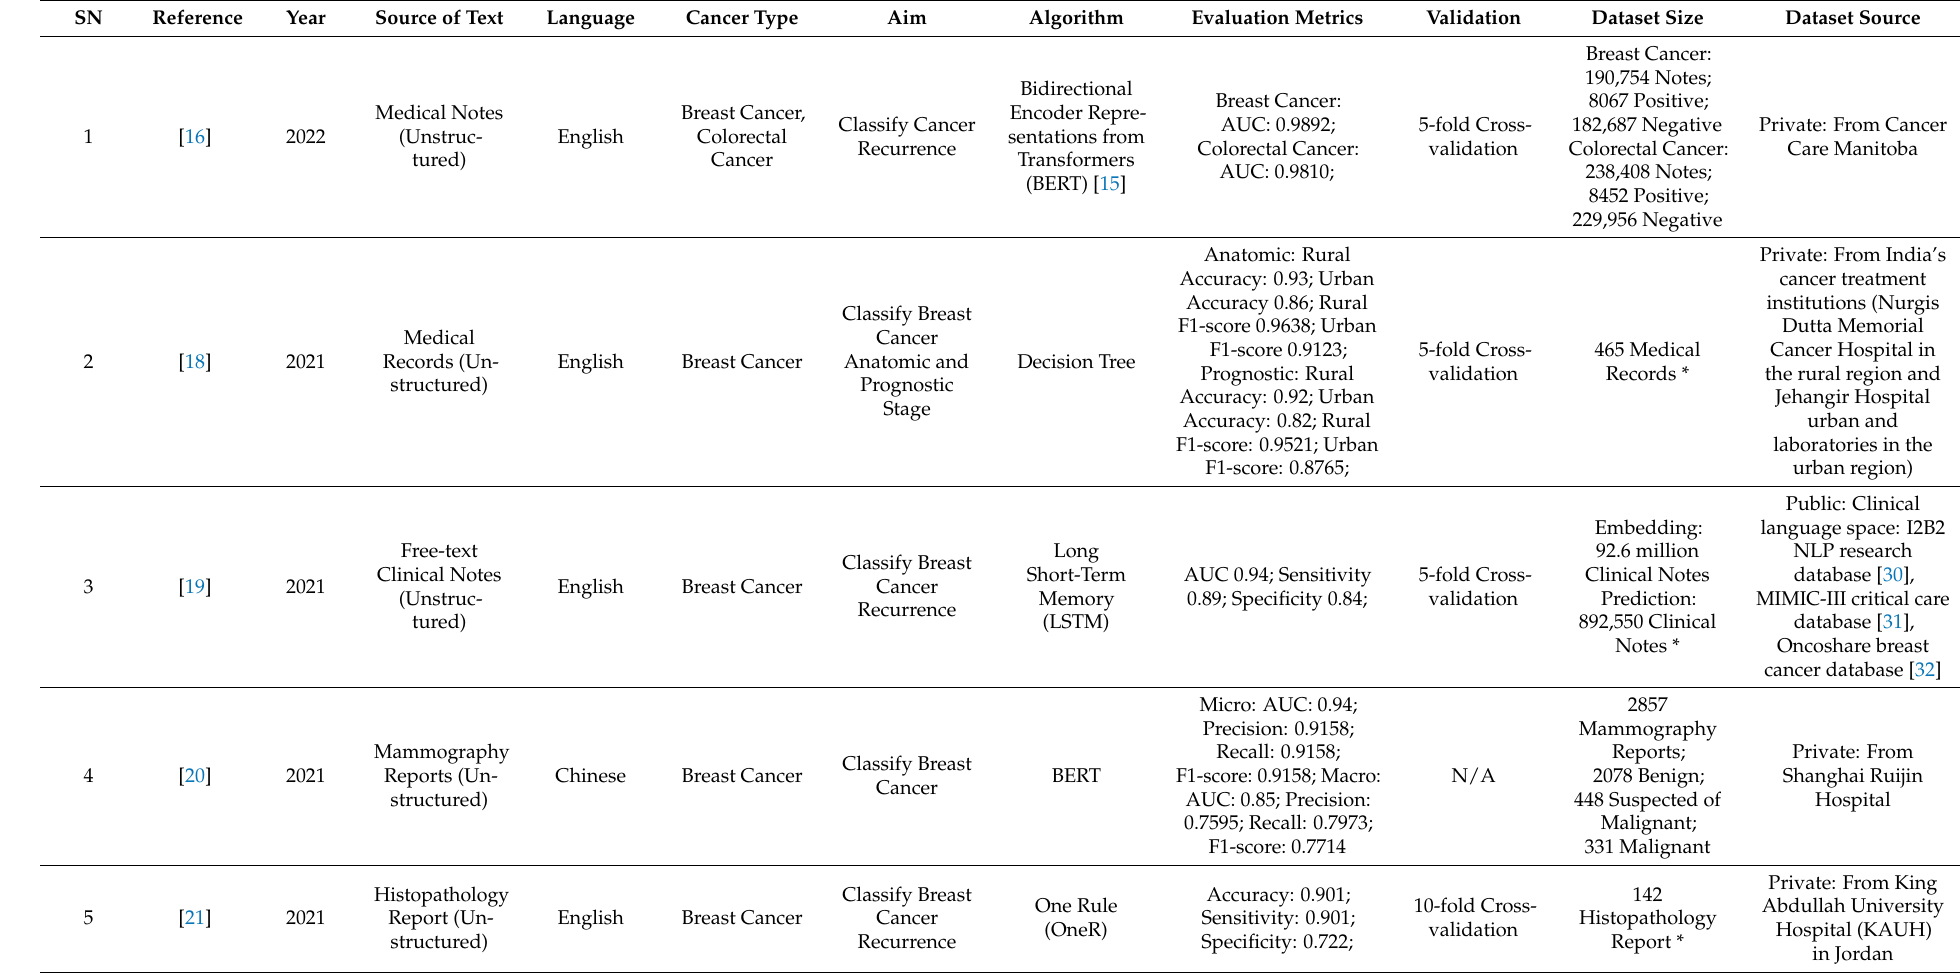
Table 3. Breast cancer-related studies. * represents that we only show the size of the dataset because the dataset has too many types of data (more than three), the distribution of the dataset is not fully described, or it is not easy to show the structure of the dataset for other